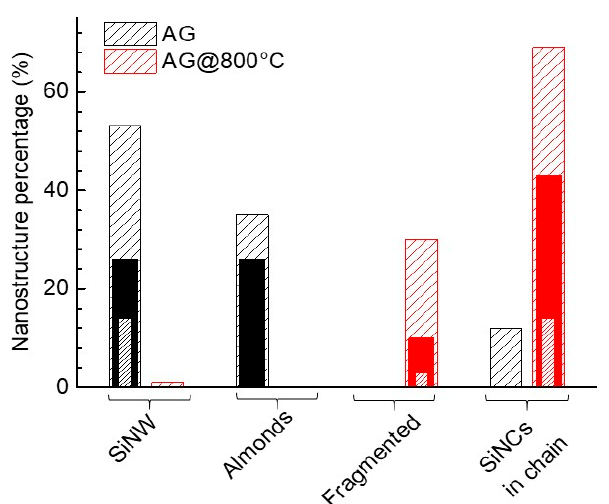
Figure 2. Percentage of SiNW, Almonds, Fragmented SiNWs and SiNCs in chain (sparse diagonals), percentage of each type of SiNS with diameter d ≤ 5 nm (solid field) and with d ≤ 3 nm (dense diagonals) for the AG (black) and AG@800 °C (red).